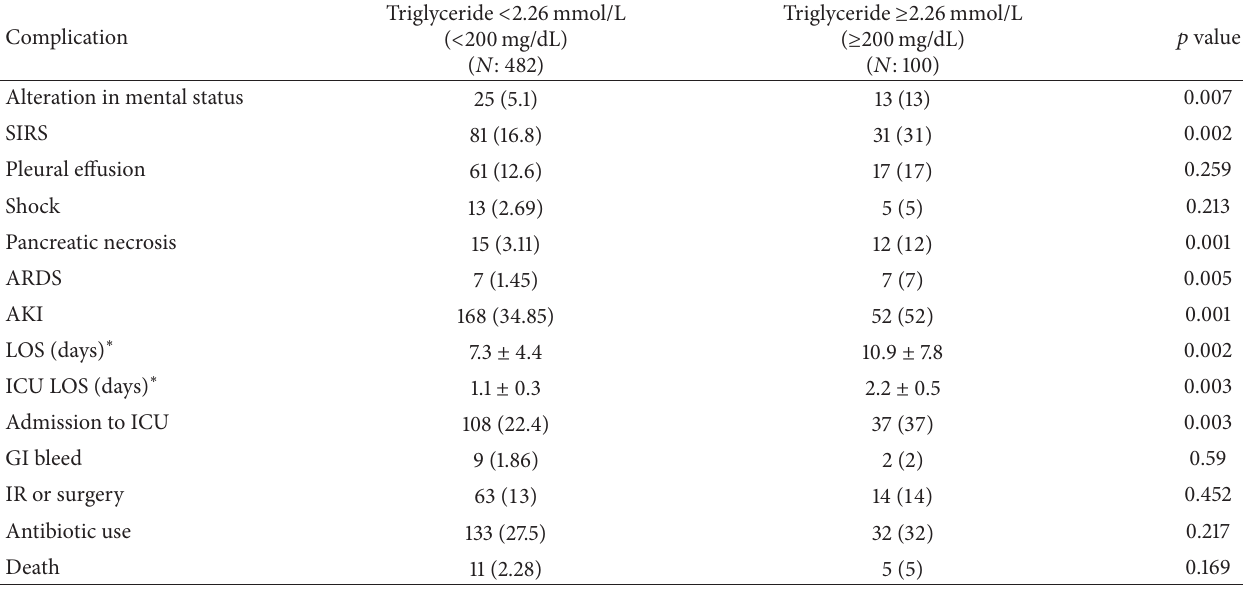
Table 3: Incidence of complications in the two study